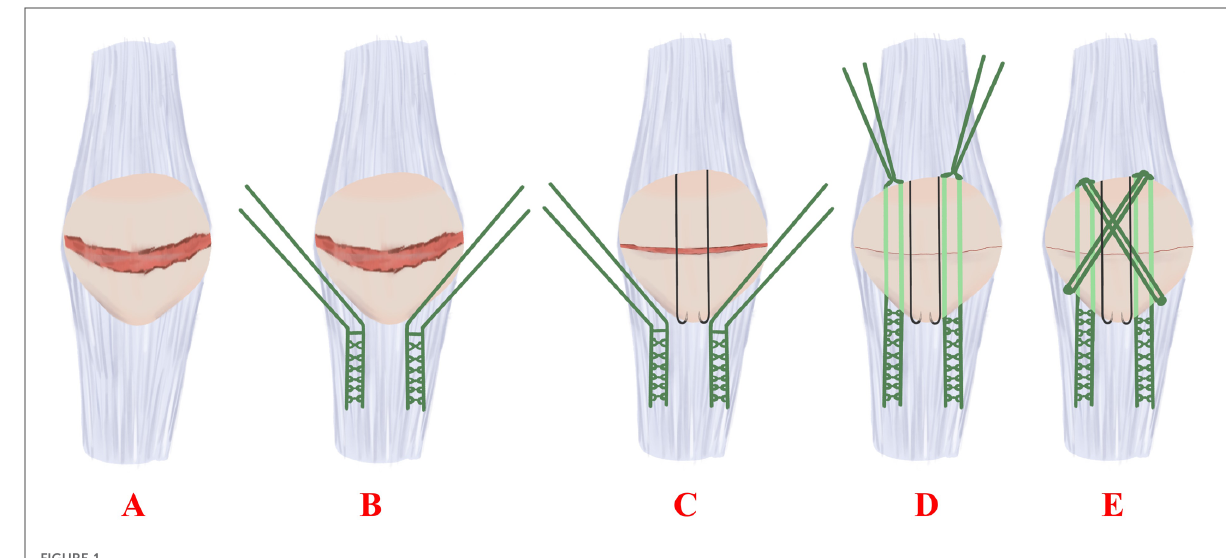
FIGURE 1 ( A – E ) Illustrations: surgical technique.